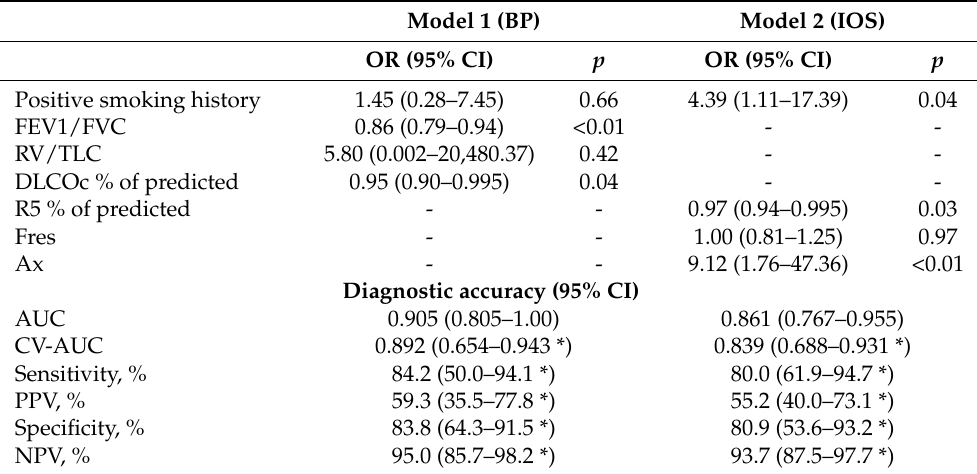
Table 3. The two multivariate logistic regression models to discriminate between presence and absence of emphysema on CT scan.